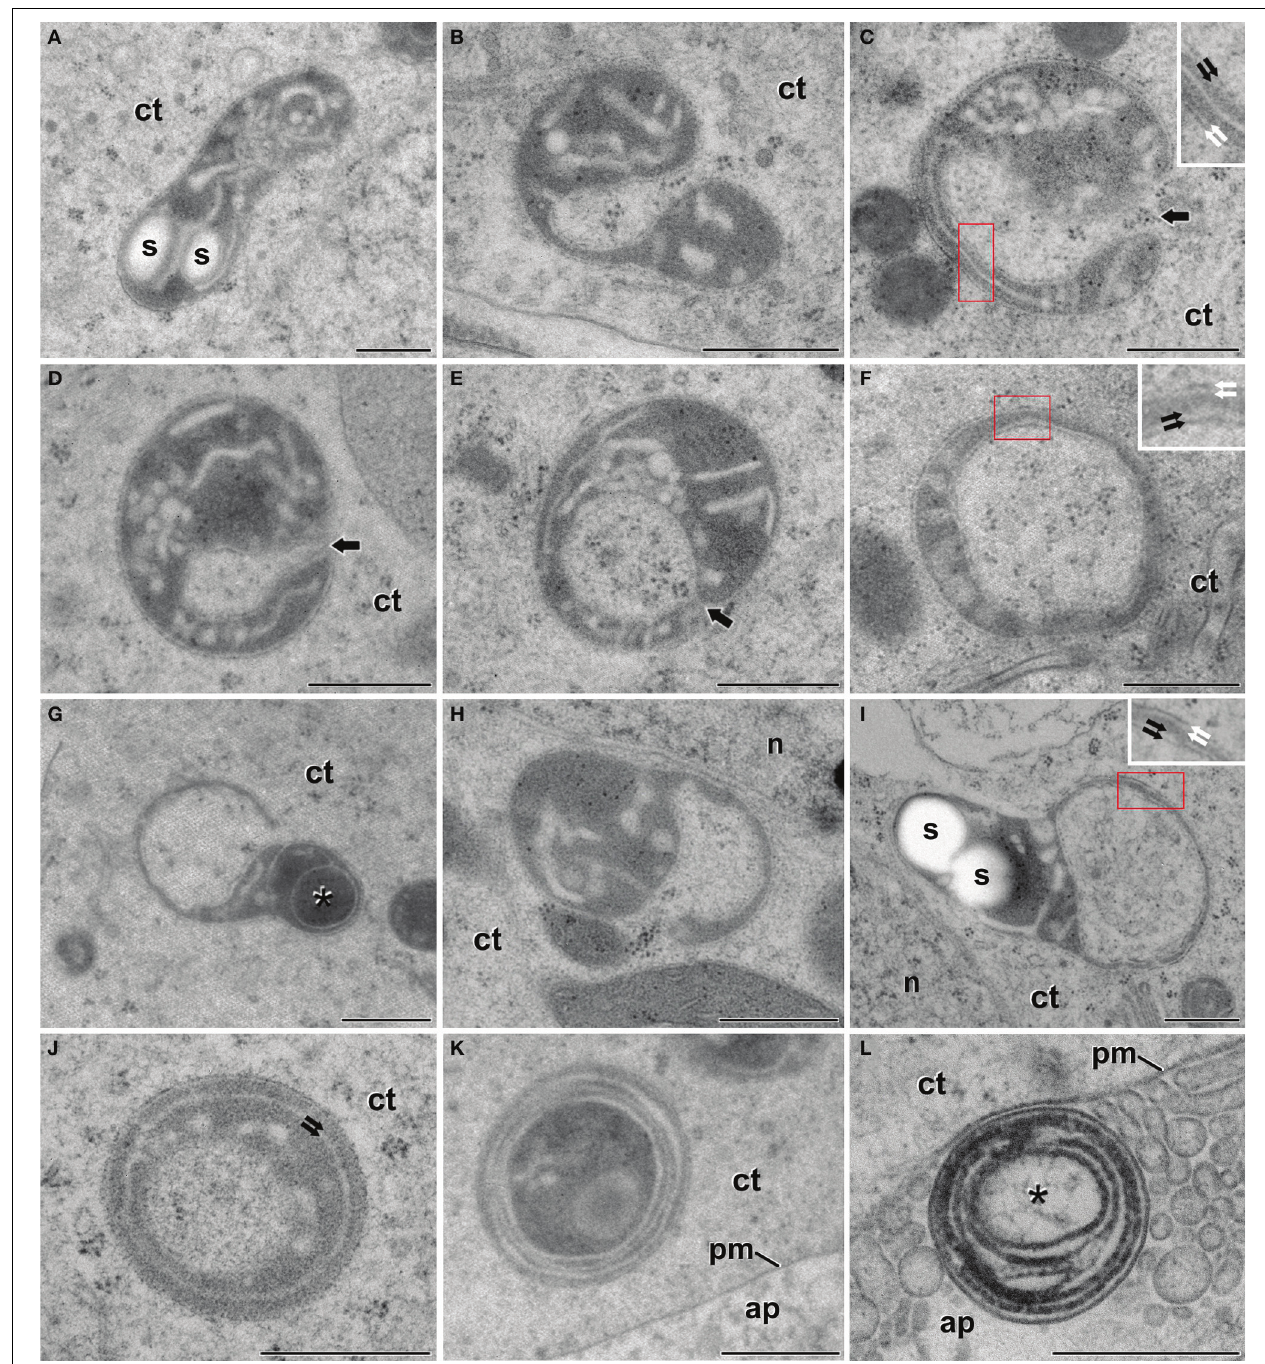
FIGURE 3 | Plastids of B. napus embryogenic microspores. (A) Shows a conventional, elongated plastid, with two small starch deposits (s). (B) Dumbbell-shaped plastid curled to engulf a small cytoplasm region. (C,D) Plastids wrapped around a cytoplasmic region. Arrows indicate the thin cytoplasmic channel that still connects the engulfed cytoplasm. (E) Plastid engulfing a cytoplasmic region. Note that the connection between the trapped region and the cell cytoplasm is almost broken, but the point of closure is still evident (arrow). (F) Plastid showing an isolated cytoplasmic region. (G,H) Plastids engulfing large cytoplasmic regions. The asterisk in (G) indicates an electron dense cytoplasmic compartment. (I) Deformed plastid with a large cytoplasmic region entirely engulfed. (J) Plastid where the internal compartment contains